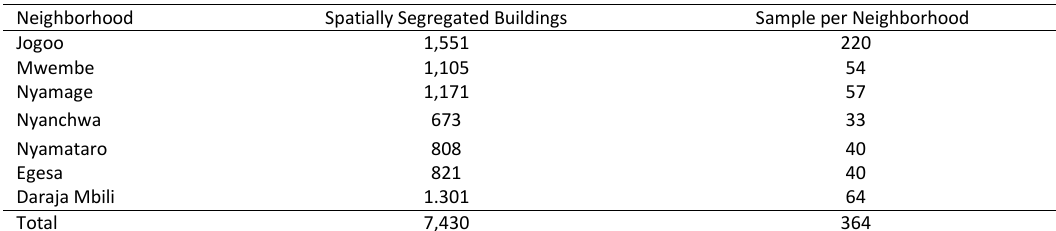
Table 1: Proportional sample size per neighborhood